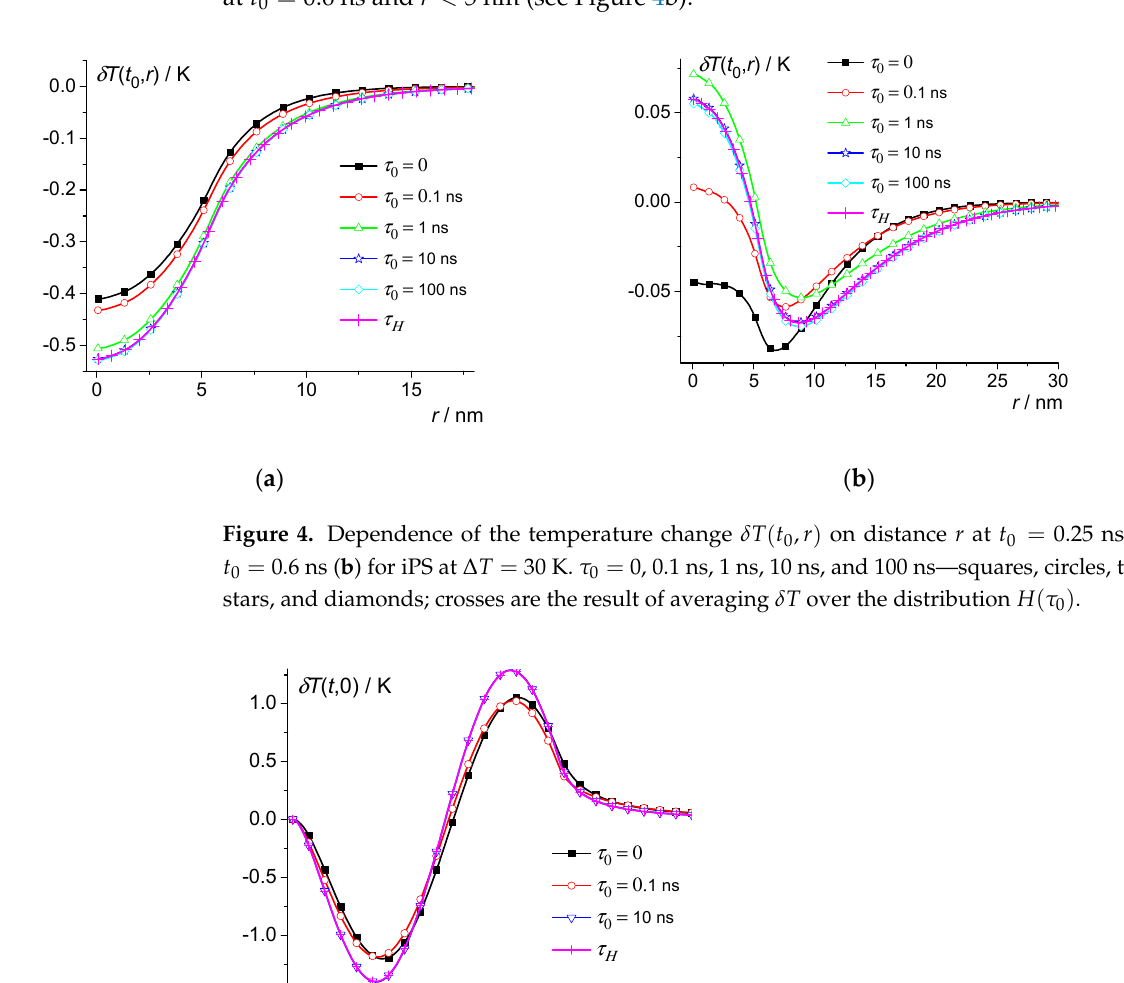
Figure 4. Dependence of the temperature change 𝛿𝑇(𝑡 (cid:2868) ,𝑟) on distance 𝑟 at 𝑡 (cid:2868) = 0.25 ns ( a ) and 𝑡 (cid:2868) = 0.6 ns ( b ) for iPS at ∆𝑇 = 30 K. 𝜏 (cid:2868) = 0, 0.1 ns, 1 ns, 10 ns, and 100 ns—squares, circles, trian- gles, stars, and diamonds; crosses are the result of averaging 𝛿𝑇 over the distribution 𝐻(𝜏 (cid:2868) ) .